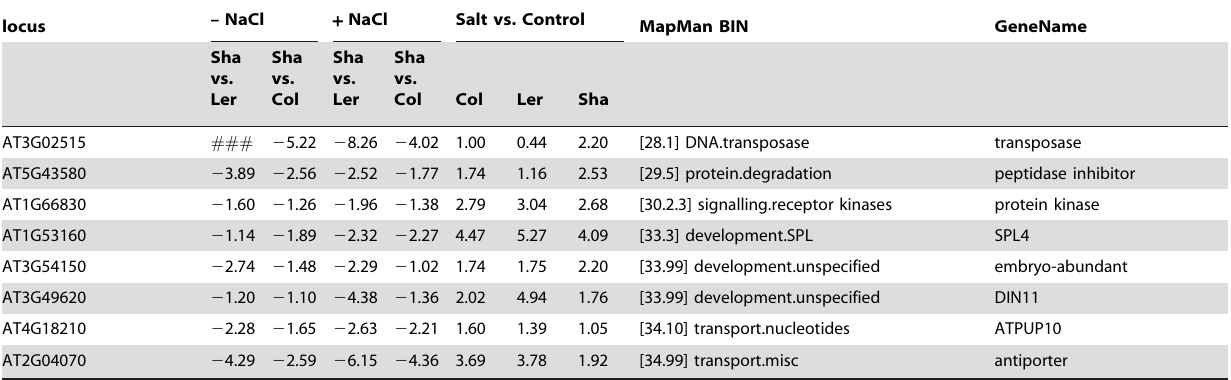
Black background means an increase (denoted by up-regulation in the heading) in transcript abundance, and grey background means a decrease (denoted by the heading down-regulation) in transcript abundance. Fold changes are log 2 values.